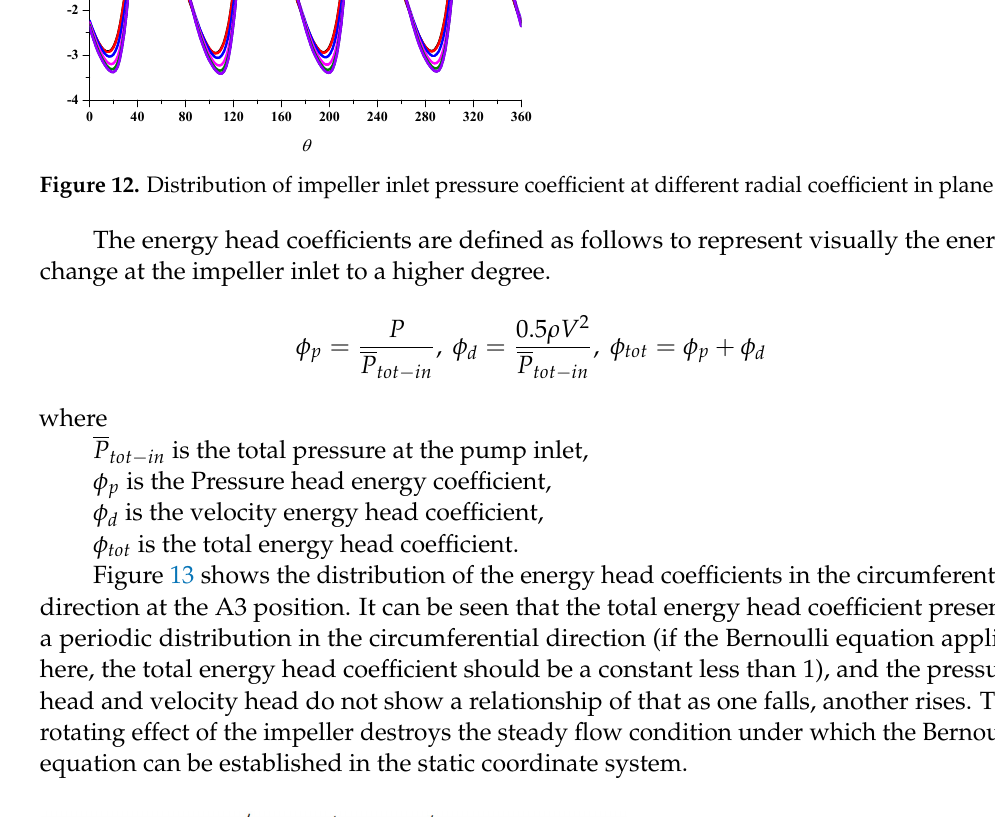
A and A are the flow area where the in out